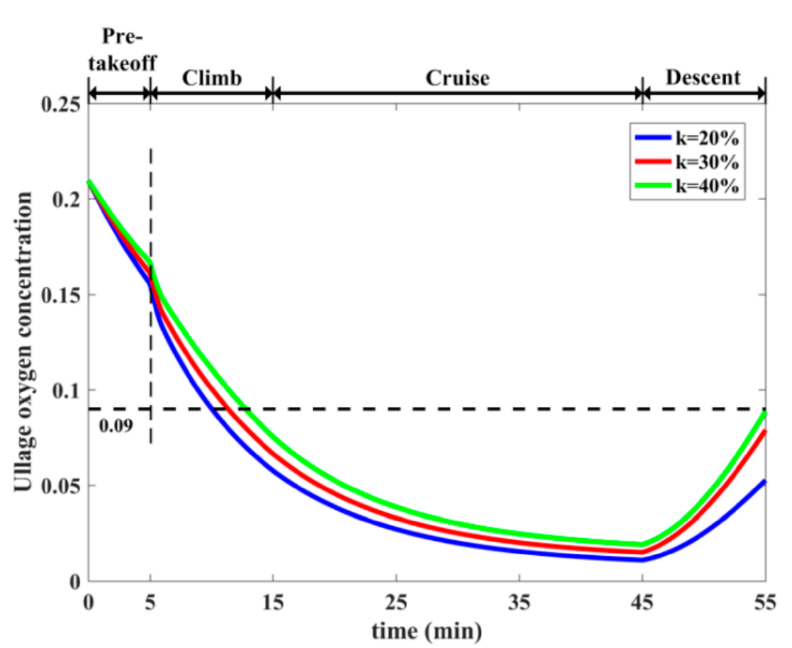
Figure 9. The ullage oxygen concentration regarding oxygen concentration of NEA, with a 5 min . v I = 0.2 m 3 /min, and the fuel load of 80%. ground-based inerting, Table 7. The boundary condition of the ullage oxygen concentration analysis regarding the oxygen concentration of NEA. Item Value Unit Ground-based inerting duration . v The volume inflow rate of NEA